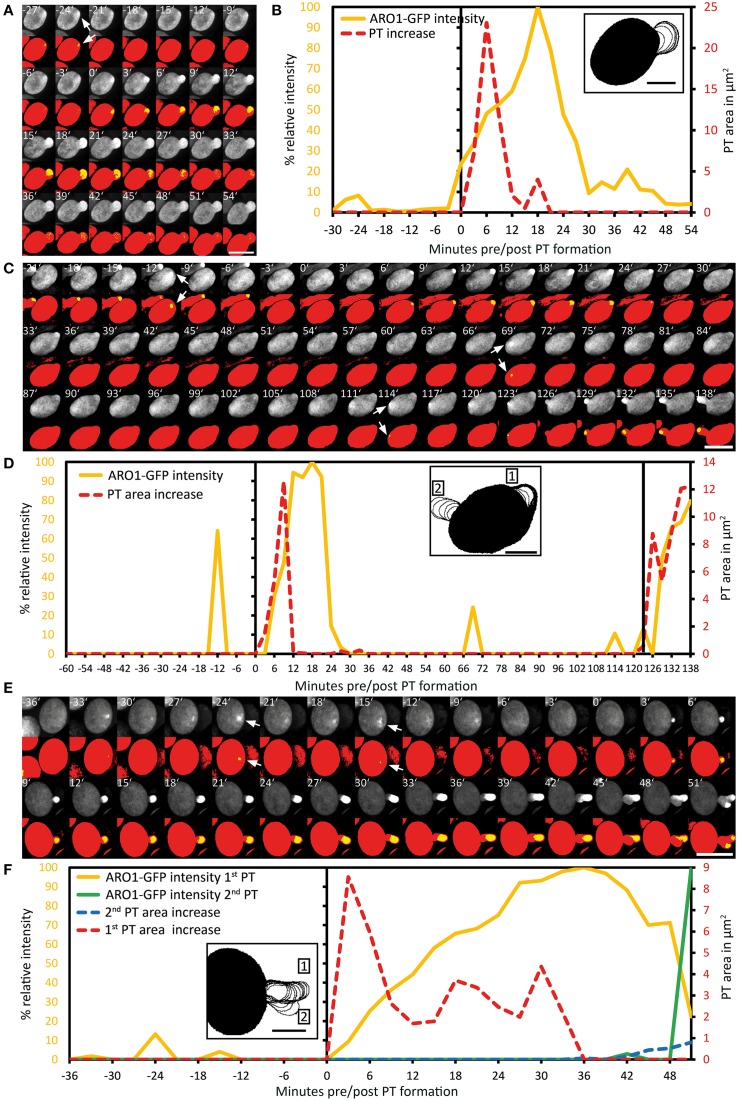
Exceptional pollen germination events confirm the correlation between local vesicle accumulation and pollen tube emergence. The breakdown of vesicle accumulation in the pollen tube bulge is accompanied with the failure to switch to rapid PT tip growth (A,B). After unsuccessful transition to rapid PT tip growth, the pollen cell may also change the direction of polar vesicle trafficking, resulting in the establishment of a second germination site, as shown in (C,D). A branching pollen tube is shown in (E,F). After successful bulging the transition to rapid PT tip growth fails and a second growth site is selected, indicated by the accumulation of ARO1-GFP decorated vesicles in the tip of the PT branch. Maximum intensity projected fluorescence raw images and composite thresholded images are shown in (A,C,E). GFP fluorescence is shown in yellow (0.5% of highest intensities) and in red (70% of highest intensities), representing the ARO1-GFP maxima and the pollen cytoplasm. Frame-wise PT area increase and relative ARO1-GFP intensity are shown in (B,D,F), where insets show frame-wise overlaid PT shape outlines. Time point 0′ indicates the last frame before germination. Arrows point to ARO1-GFP intensity maxima before germination. Scale bars: (A,C,E) 25 μm, insets in (B,D,F) 10 μm.